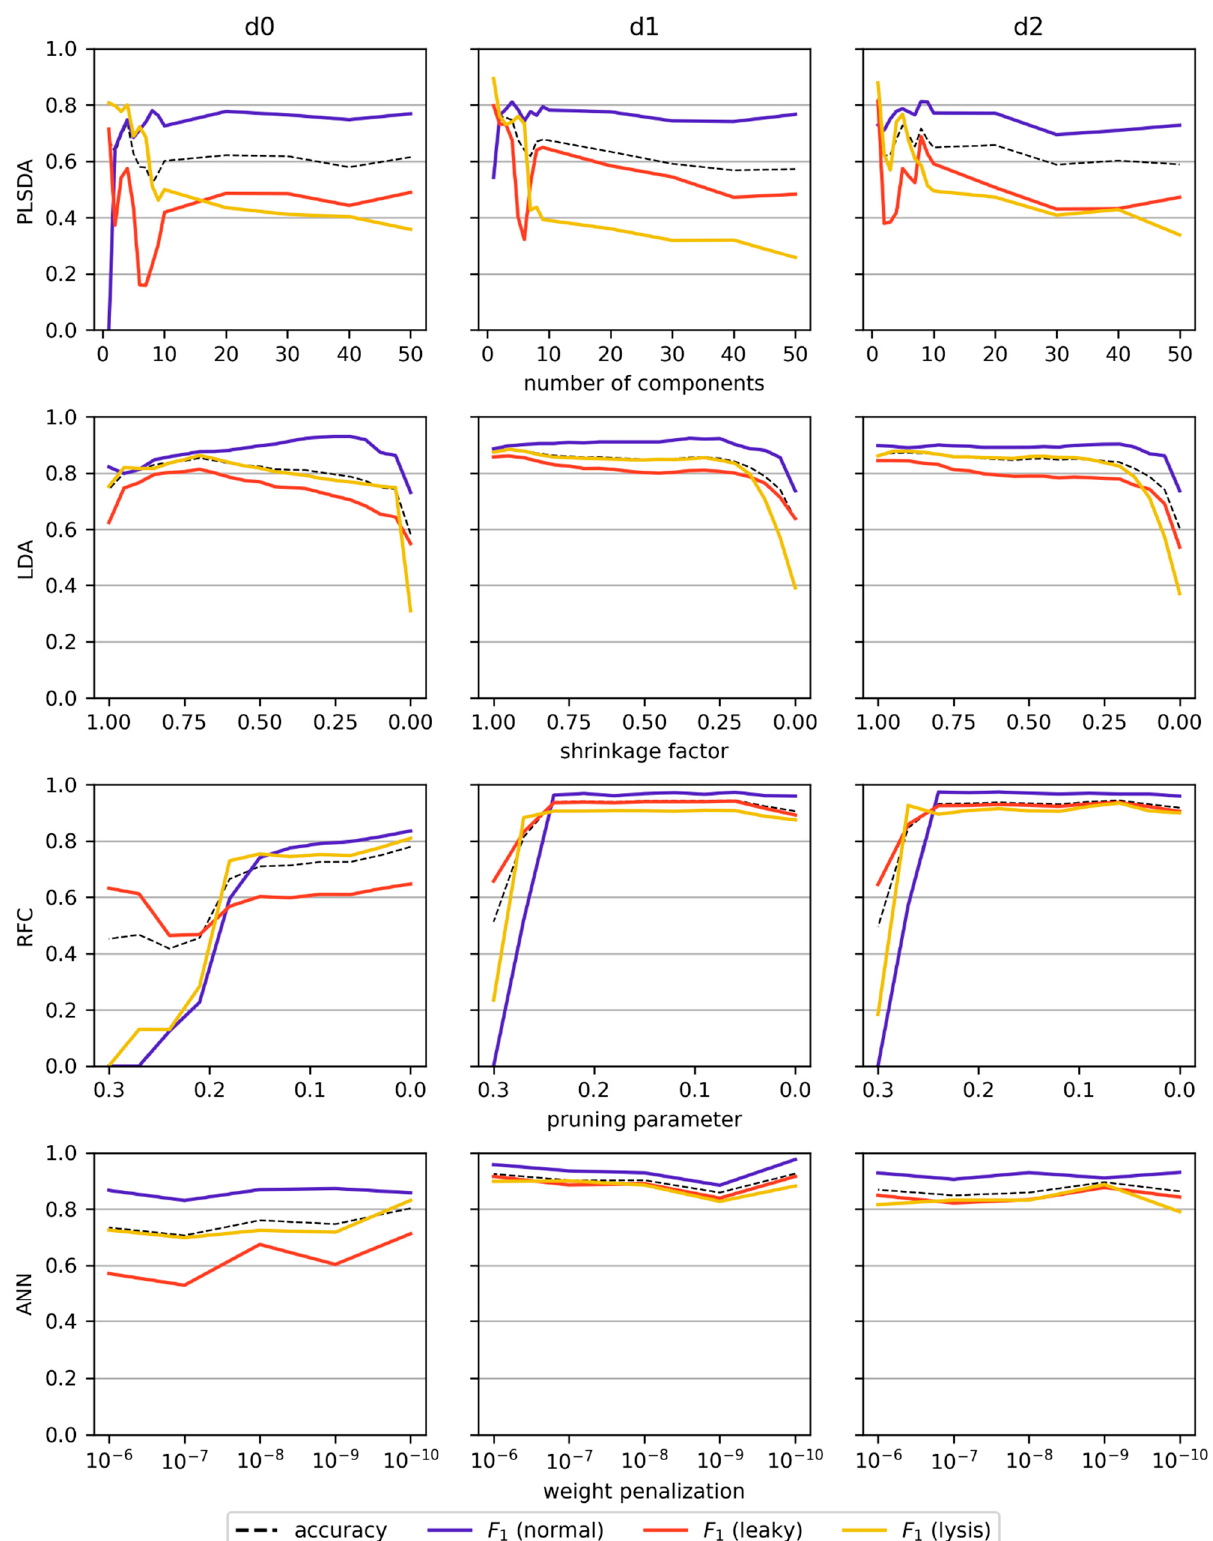
Figure 6. Classification performance of the different models trained and tested with the baseline-corrected post-induction spectra vs. different degrees of complexity. The x-axes are oriented such that the least complex model is on the left side and the most complex on the right side. The evaluation metrics were averaged over the six data splits (one for each run), weighted by the number of samples in each run (accuracy) or the frequency of classes in each run ( F 1 score).